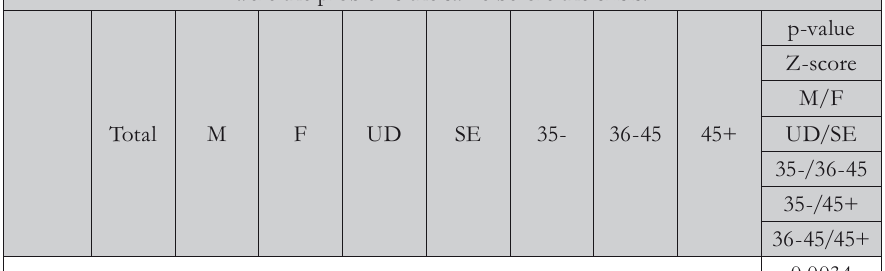
Tab. 3 – Problems with the payment discipline before and after the crisis periods. Source: own